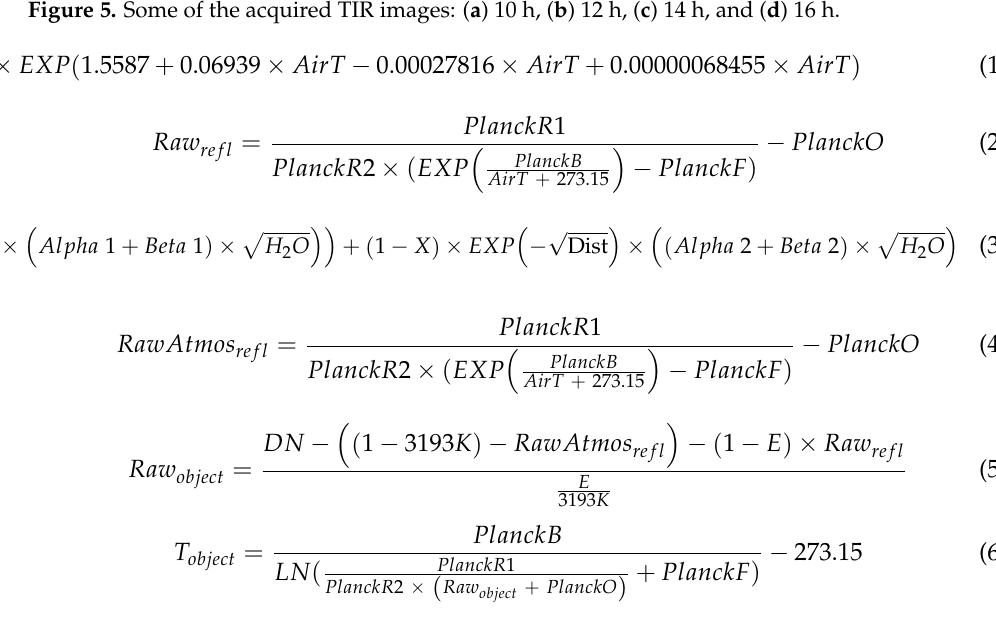
Figure 5. Some of the acquired TIR images: ( a ) 10 h, ( b ) 12 h, ( c ) 14 h, and ( d ) 16 h. H 2 O = Hum × EXP ( 1.5587 + 0.06939 × AirT − 0.00027816 × AirT + 0.00000068455 × AirT